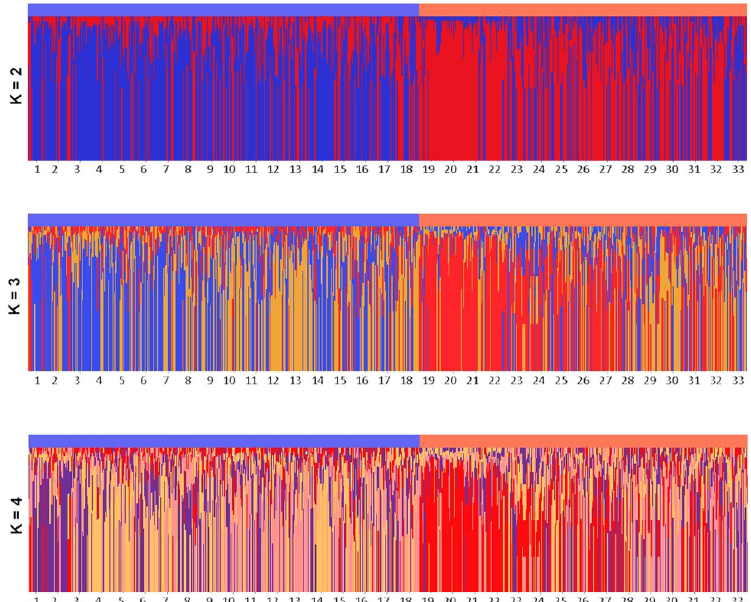
Figure 2. Bayesian cluster analysis (from K = 2 to K = 4) for all P. veris populations with a color indication for the respective habitat for each of the 33 populations visualized with Structure Plot shiny web application 96 (blue for the grassland habitat and red for the forest